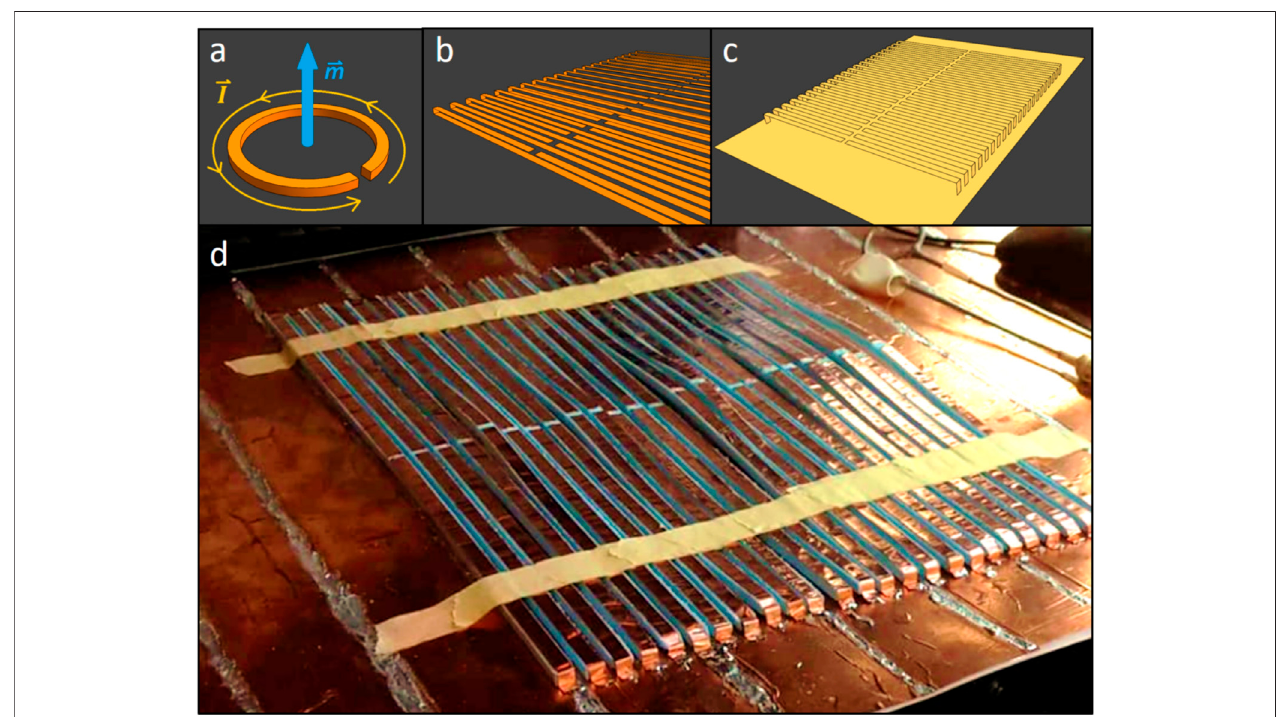
FIGURE 3 | (A) A split ring resonator, which carries current and thus is able to capture a time-varying magnetic fi eld. (B) Split ring resonators are fl attened and arranged into a period array. (C) The split ring resonators are merged with a backplate and dubbed the “ Split Ring Shield ” (SRS). (D) Photograph of the SRS under construction. The rings are made by applying copper tape to foam spacers and soldered to a copper backplate. The dimensions are as follows: ring length: 360 mm, width: 6 mm, height: 4 mm, gap size: 2 mm, and ring spacing period: 10 mm.